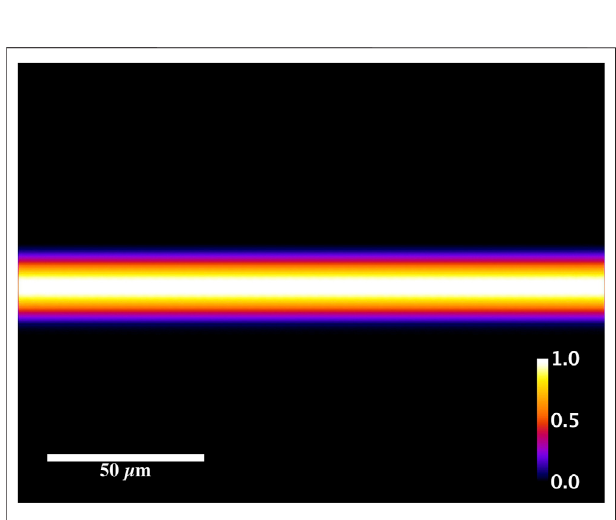
FIGURE 7 | Intensity distribution obtained with fi nite element analysis assuming a step refractive index increase along the planar waveguide at 800